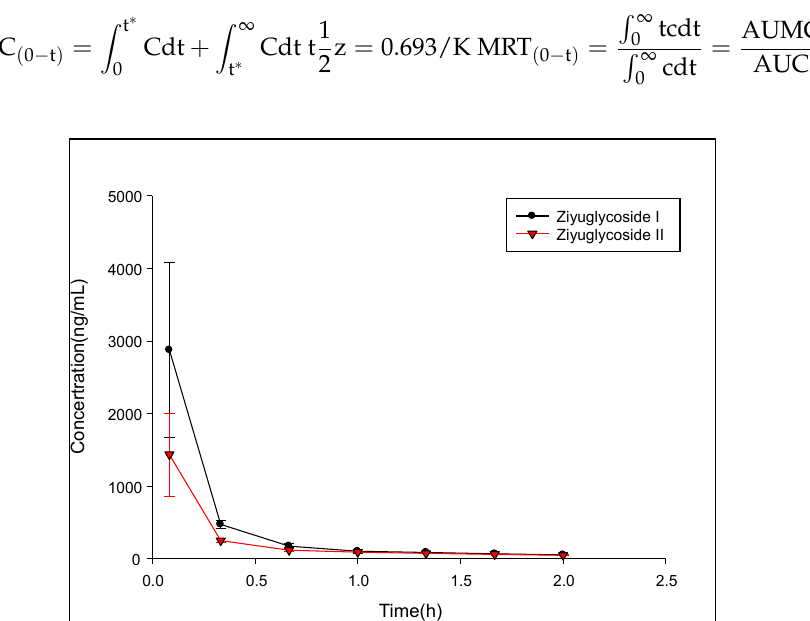
Table 8. Pharmacokinetic parameters of ZGS1 and ZGS2 in rats after subcutaneous injection administration of 10 mg/kg ZGS1 ( n = 5).